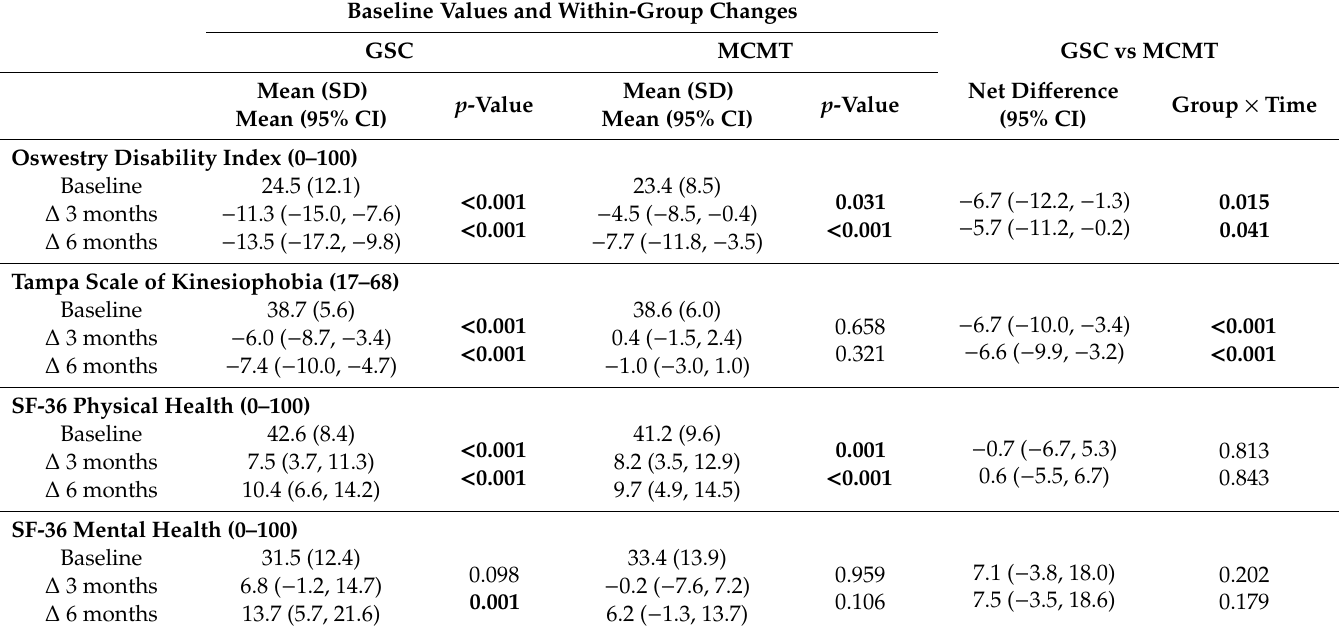
Table 3. Intent-to-treat analysis using linear mixed models on self-reported outcomes at baseline, three and six months in participants randomized to general strength and conditioning (GSC) and motor control manual therapy